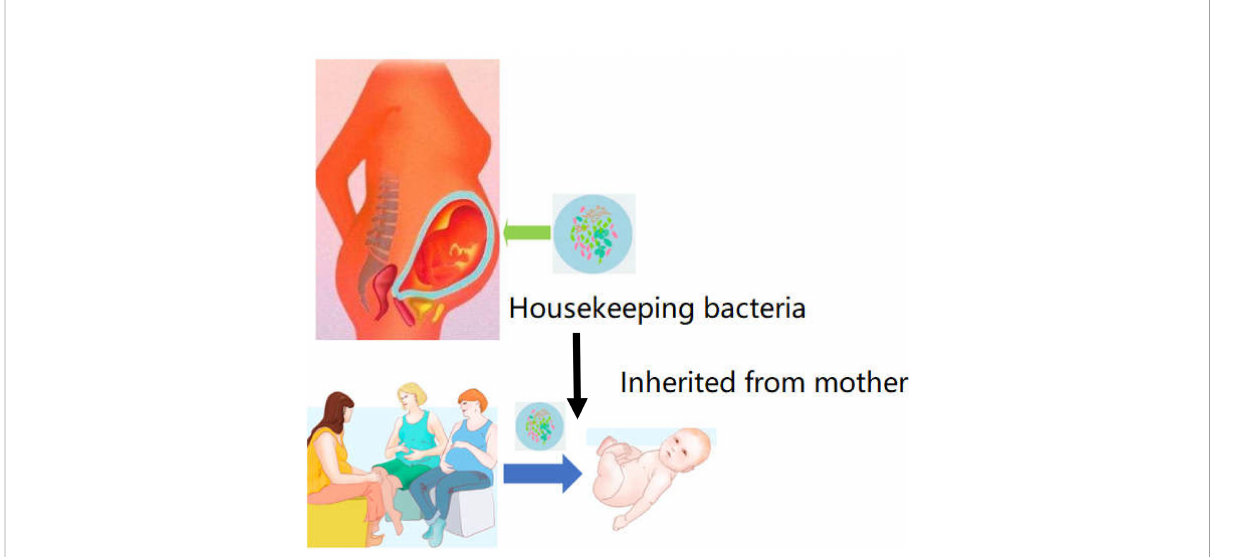
FIGURE 3 Housekeeper bacteria are the strains can be inheritable from mother to infant. Once these strains of housekeeper bacteria can be acquired from the placenta or amniotic fl uid. The bacteria could be founded as a primary microbiome data to cure and prevent the dysbiosis in future GIT